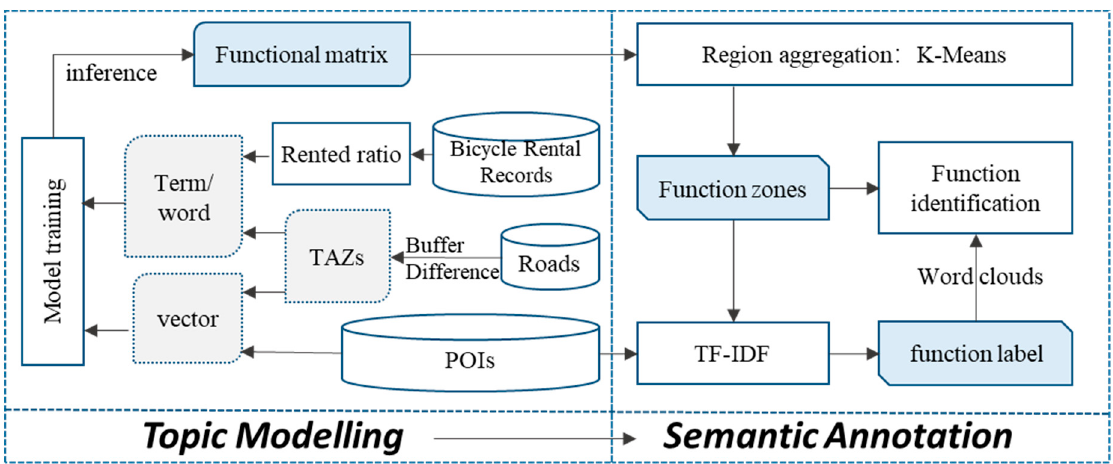
Figure 3. The analysis framework.